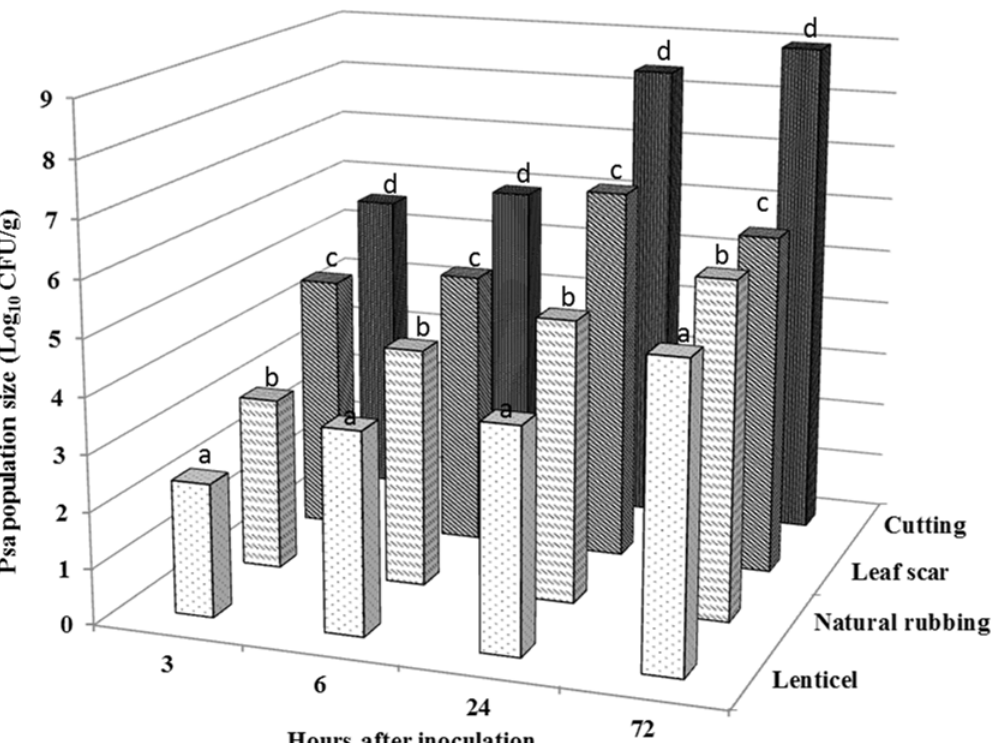
Fig 1. Population size of the GFPuv-labeled Psa in kiwifruit twigs after inoculation of different wound types. The GFPuv-labeled Psa were isolated and cultured in BPA plates supplemented with KAN (50 μ g (cid:1) mL − 1 ) and colonies were counted under the fluorescence microscope. Values in columns followed by different letters were significantly different according to Fisher ’ s protected LSD test among lenticel, natural rubbing, leaf scar and cutting (P = 0.05).